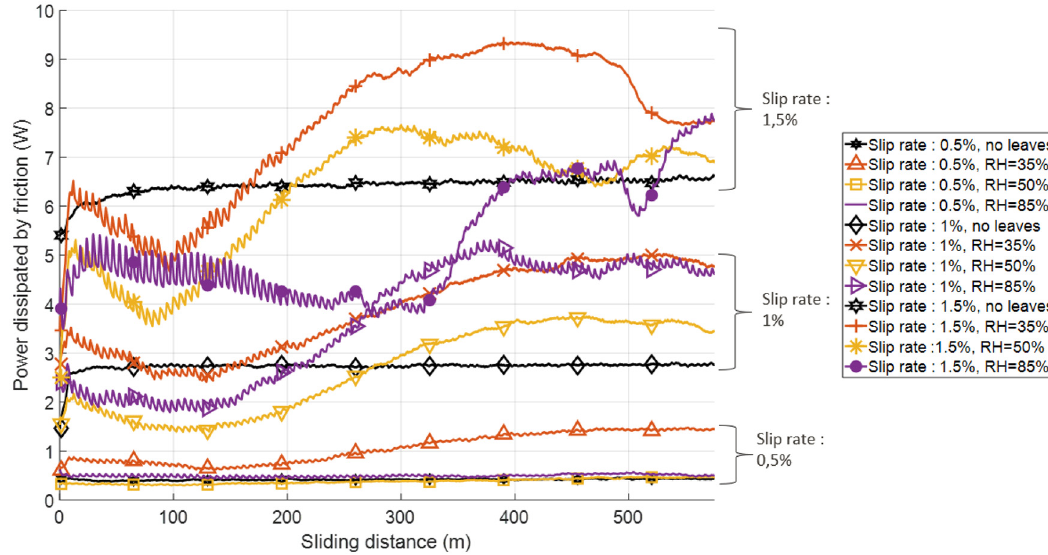
Fig. 16. Power dissipated by friction, all RH and slip rates (tests described in Tab. 4).